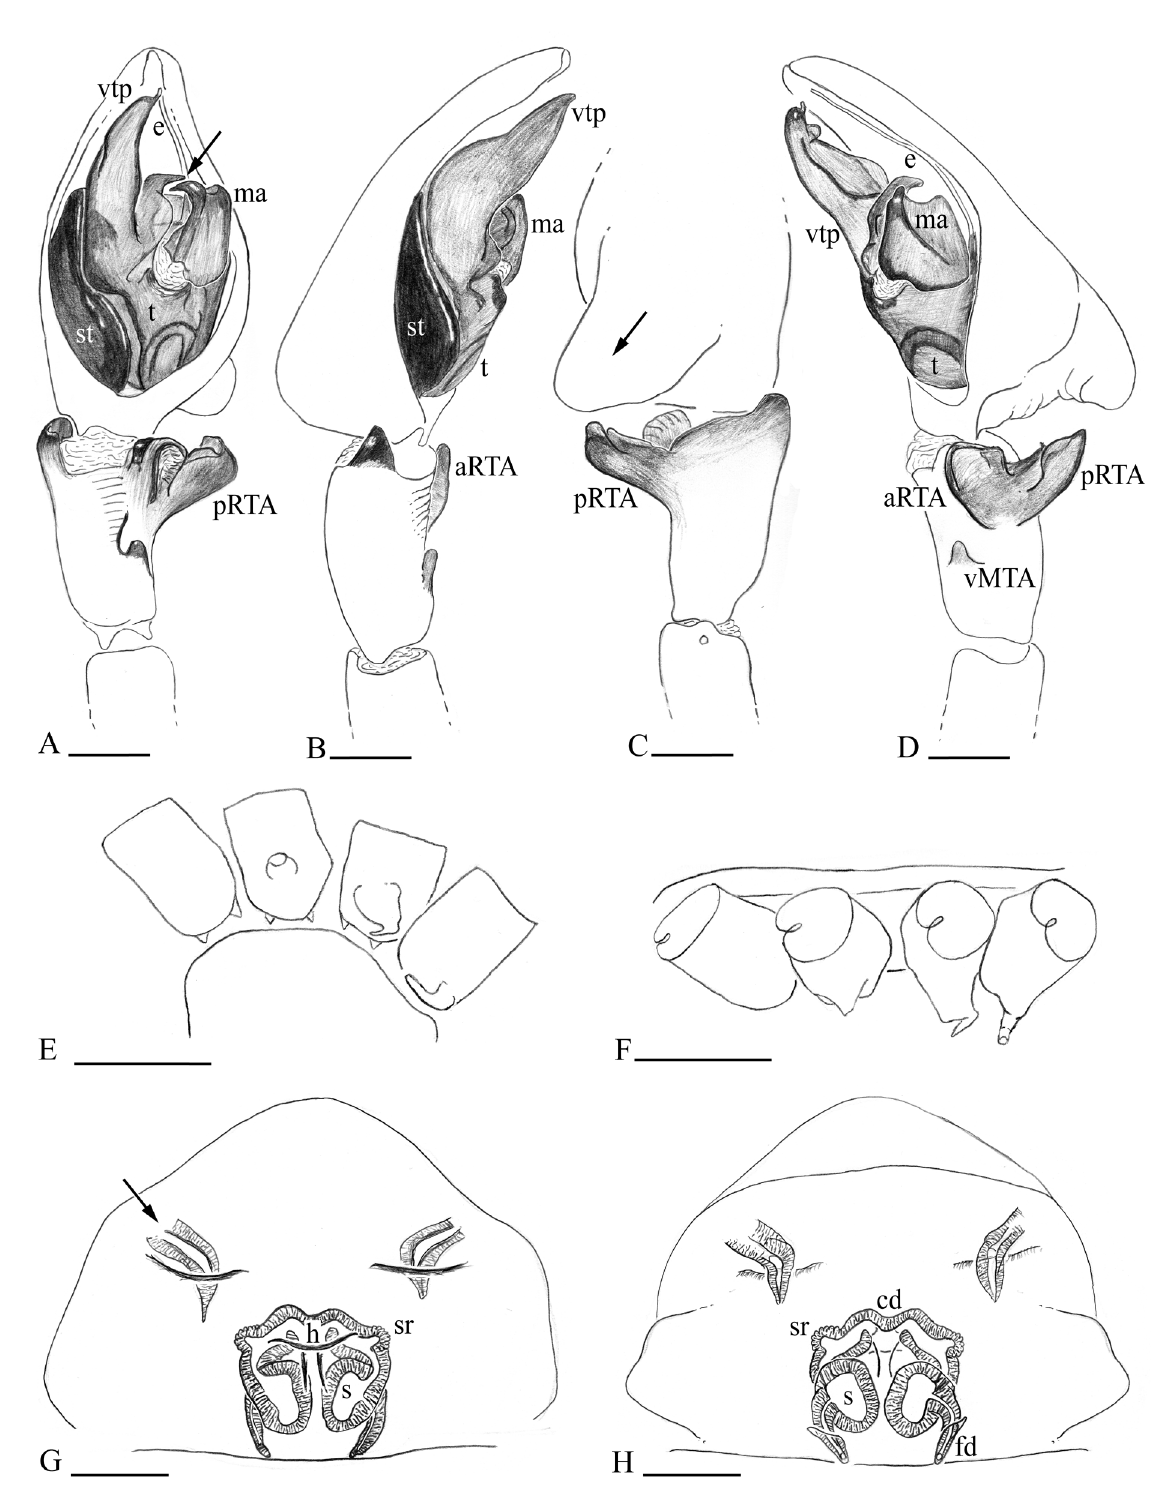
Fig. 12. Anyphaena triangularis sp. nov. A–F . Paratype, ♂ (CNAN-T01577). G–H . Paratype, ♀ (CNAN-T01579). A . Pedipalp, ventral view. B . Pedipalp, prolateral view. C . Pedipalp, dorsal view. D . Pedipalp, retrolateral view. E . Coxae, ventral view. F . Coxae, lateral view. G . Epigynum, ventral view. H . Epigynum, dorsal view. Scale bars: A–D, G–H = 0.2 mm; E–F = 1.0